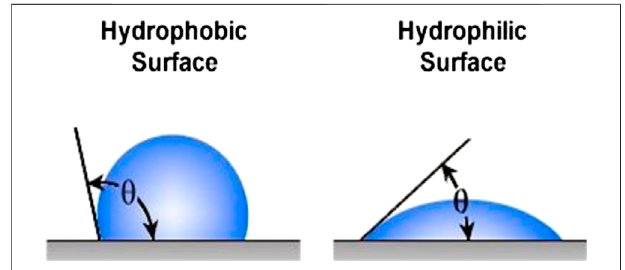
FIGURE 5 | Correlation between contact angle ( θ ) and roughness.